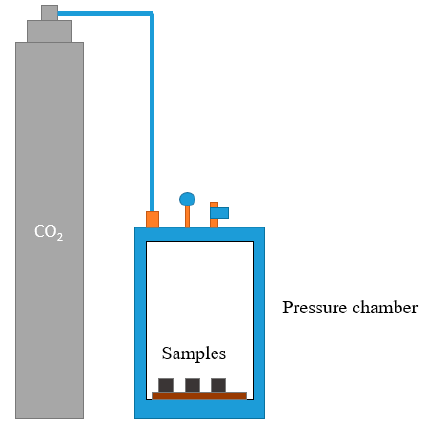
Figure 2. Carbon curing set-up.